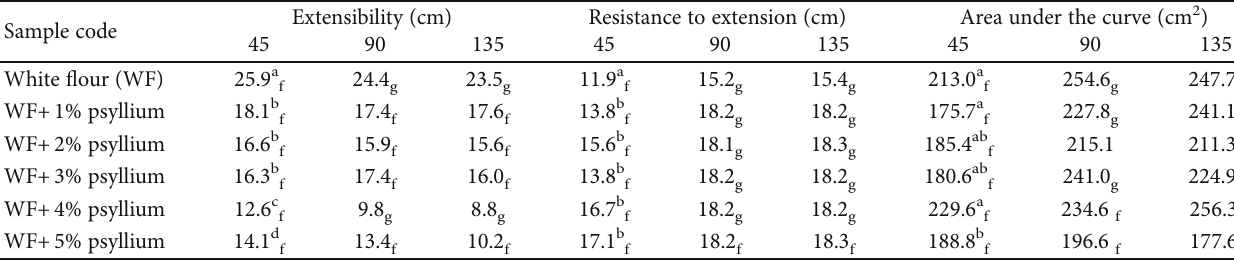
Table 8: Extensograph characteristics of dough made from fl our and psyllium blends.